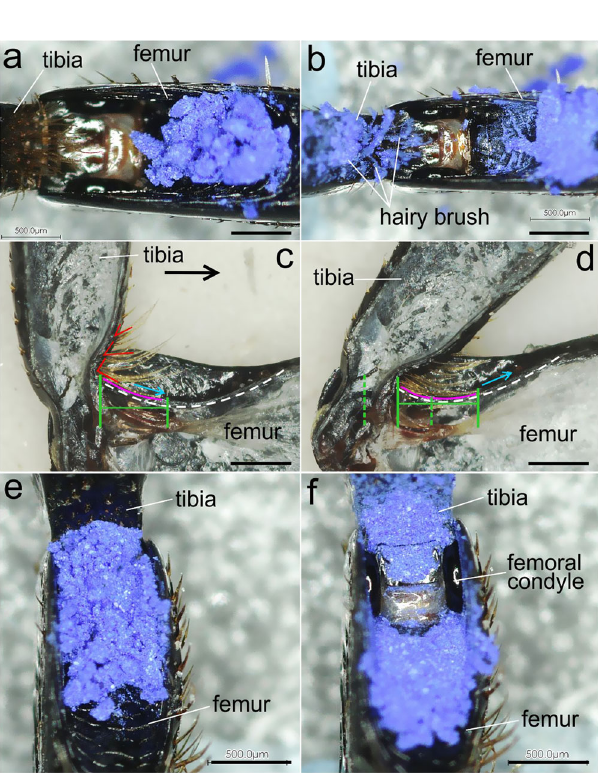
Fig. 3 Contamination experiment with hairy brush and scraper. a , b Blue iron oxide powder applied to the ventral side of femoro-tibial joint external surface: a initial position; b after ten cycles; c , d movement of the tibia and corresponding movement of long hairs of the hairy brush, dotted green lines show the displacement of hairs on the femoral surface, red angles show inclination of hairs, pink line indicates the position of a hair on the femoral surface; e , f surface of the tibia and femur covered with blue iron oxide powder: e initial position; f after ten cycles. Scale bar: a – f 500 µ